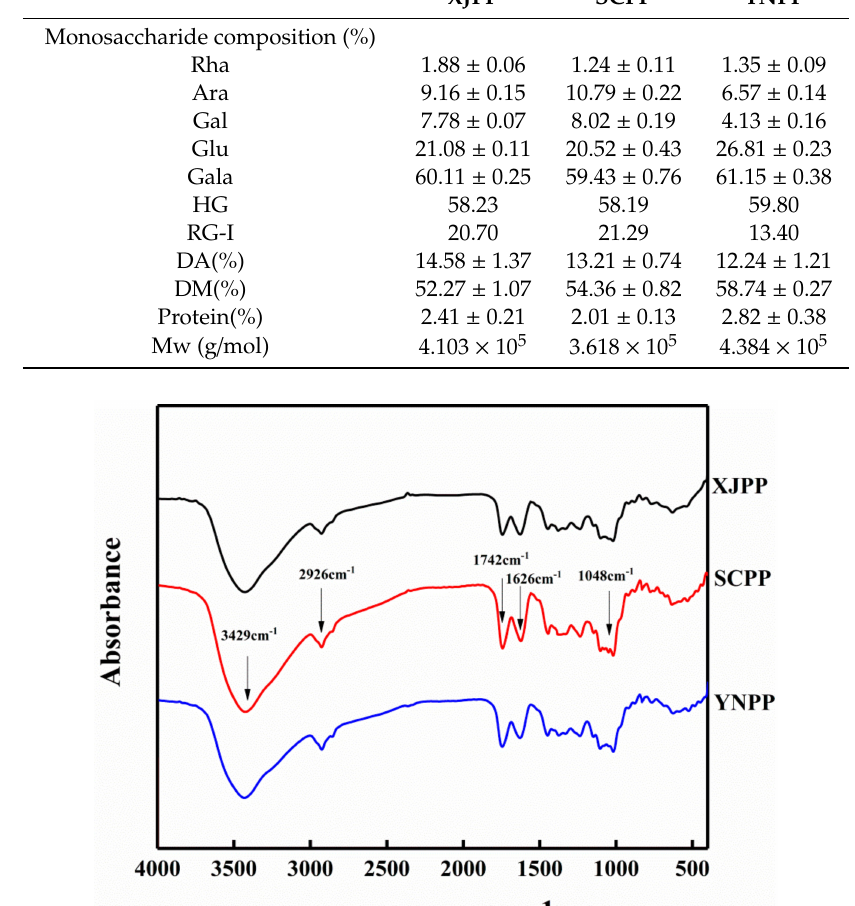
Figure 1. Pectin Fourier transform infrared (FTIR)